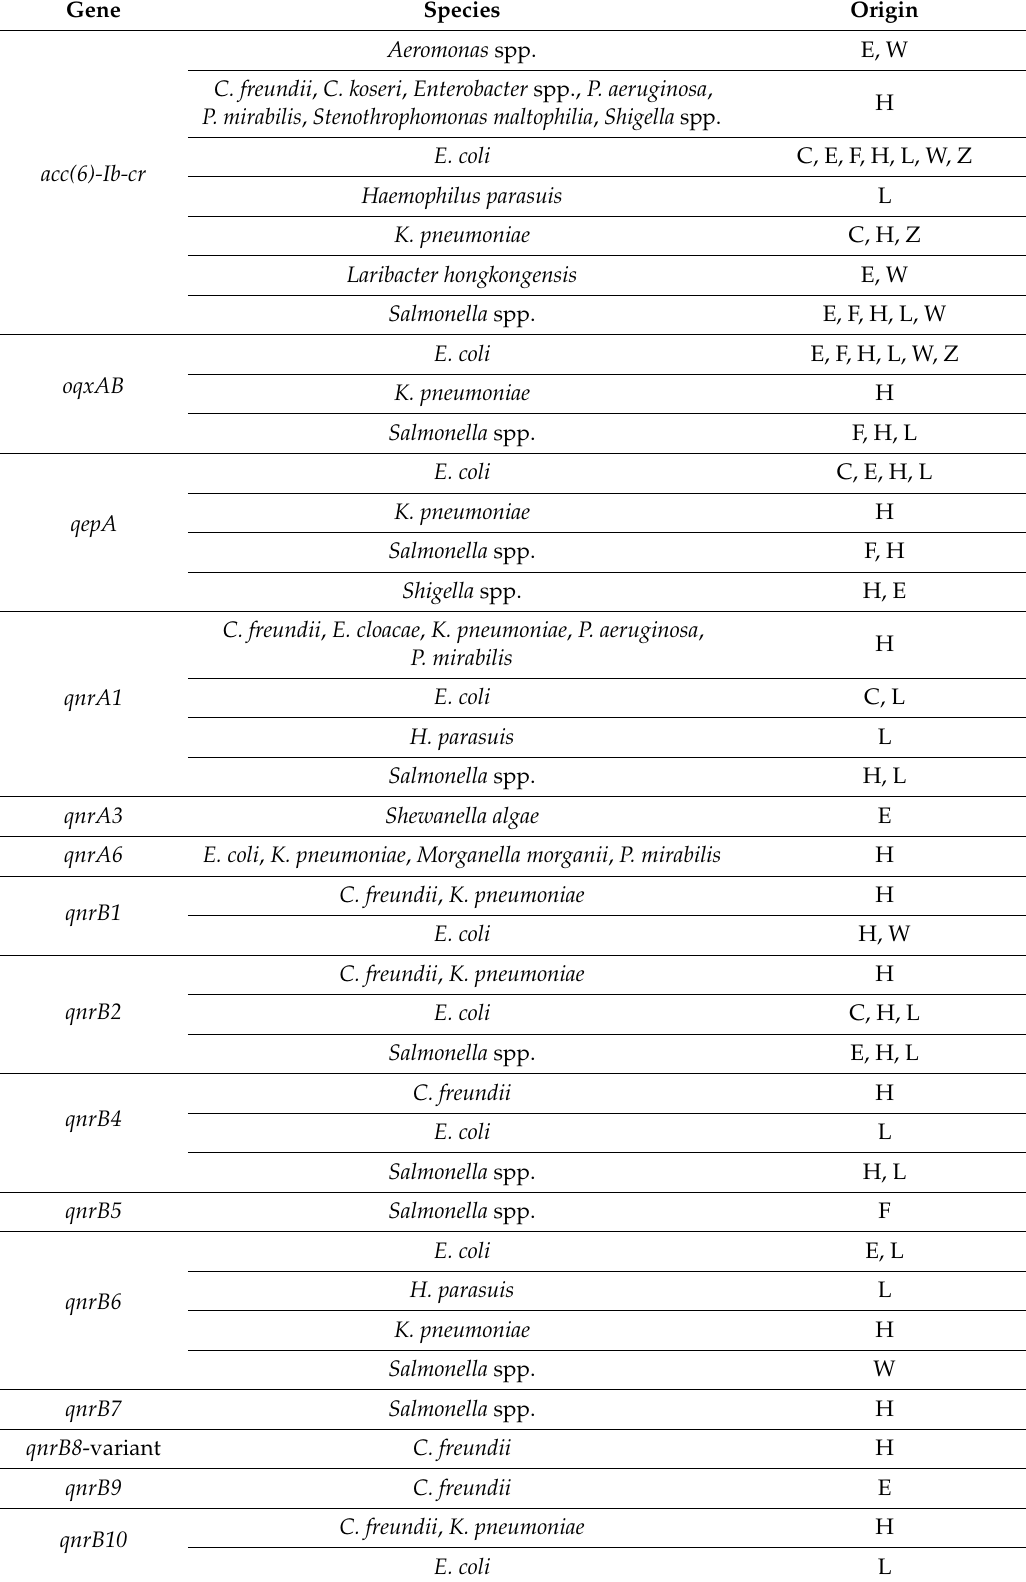
Table 9. Examples of distribution of certain